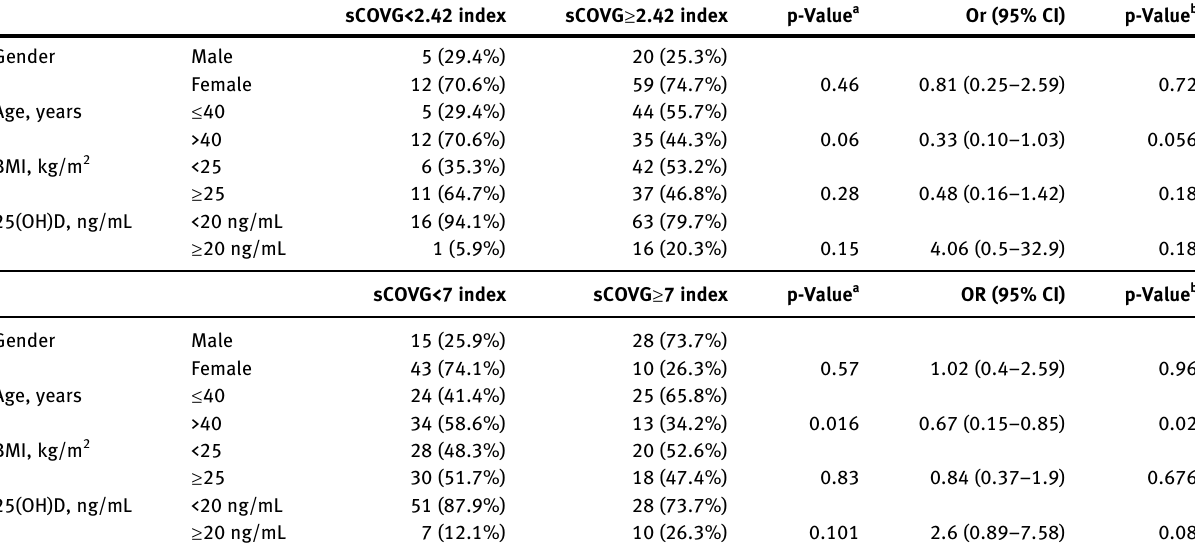
Table  : Summary of chi-square tests and binary logistic regression analysis predicting the sCOVG levels in the study group. sCOVG<  .  index sCOVG ≥  .  index p-Value a p-Value